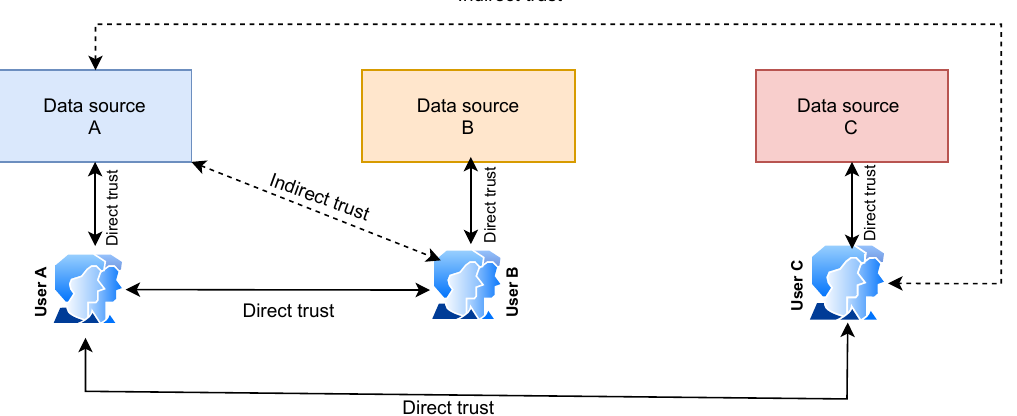
Figure 4. Difference between direct and indirect